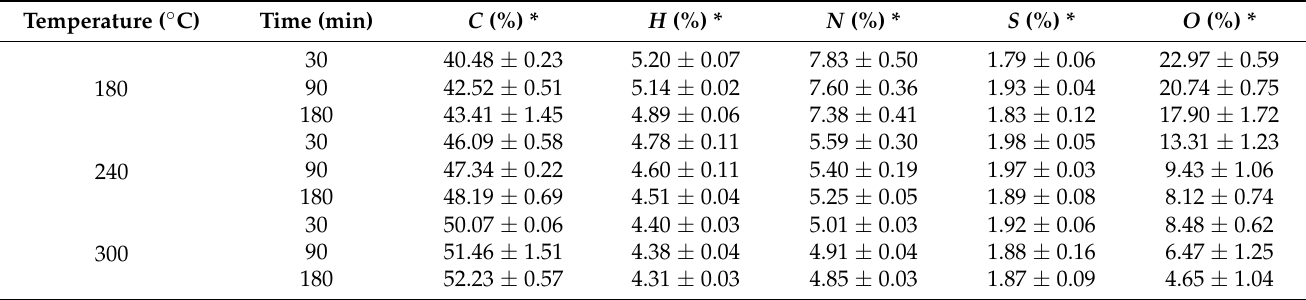
Table 3. Elemental analysis of derived